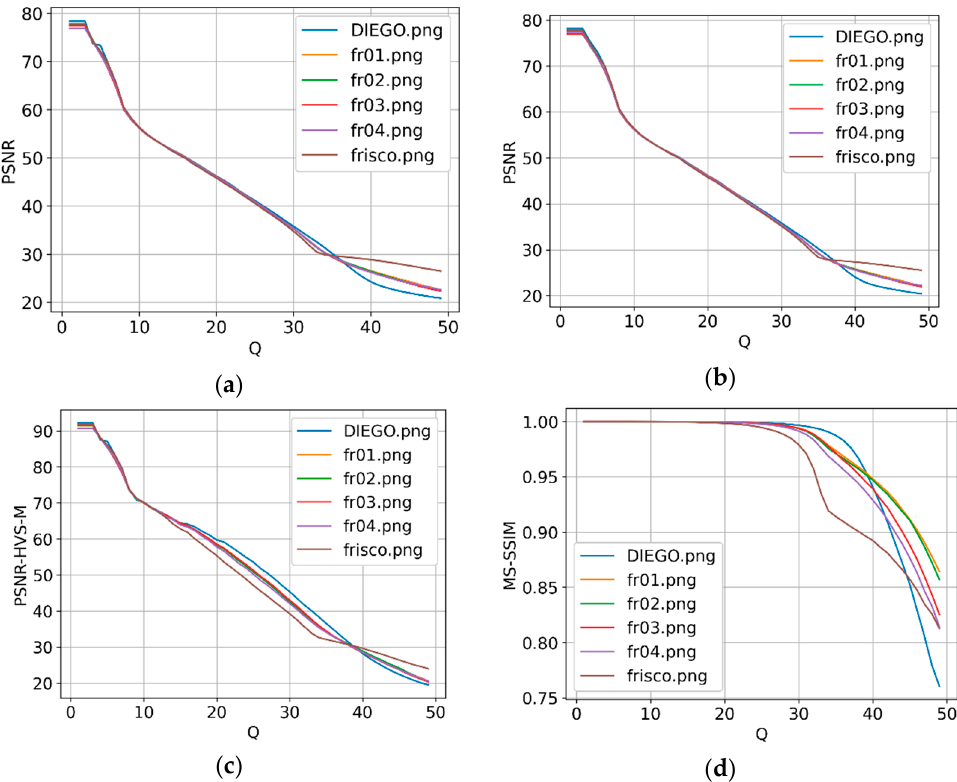
Figure 2. Dependences of the considered metrics (calculated between the original and compressed images) on Q : PSNR nc ( Q ) for noise variance equal to 64 ( a ), PSNR nc ( Q ) for noise variance equal to 100 ( b ), PSNR − HVS − M nc ( Q ) ( c ) and MS − SSIM nc ( Q ) ( d ) for noise variance equal to